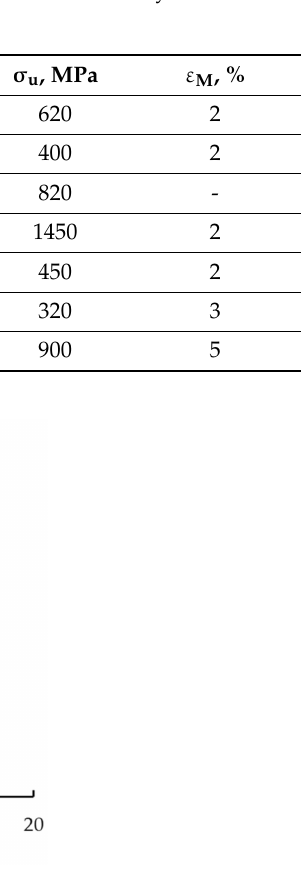
Figure 18. Stress–strain curves taken in tensile tests of the Cu-14Al-3Ni alloy after different deformation–temperature treatments: (1) forging + quenching from 1223 K; (2) repeated quenching from 1273 K; (3) HPT, n =10 rev, at 293 K; (4) HPT, n = 10 rev, at 423 K; (5) HPT, n = 10 rev, at 293 K + 1073 K, for 10